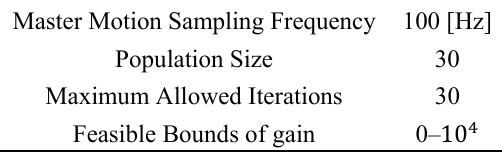
Table 4. Optimization